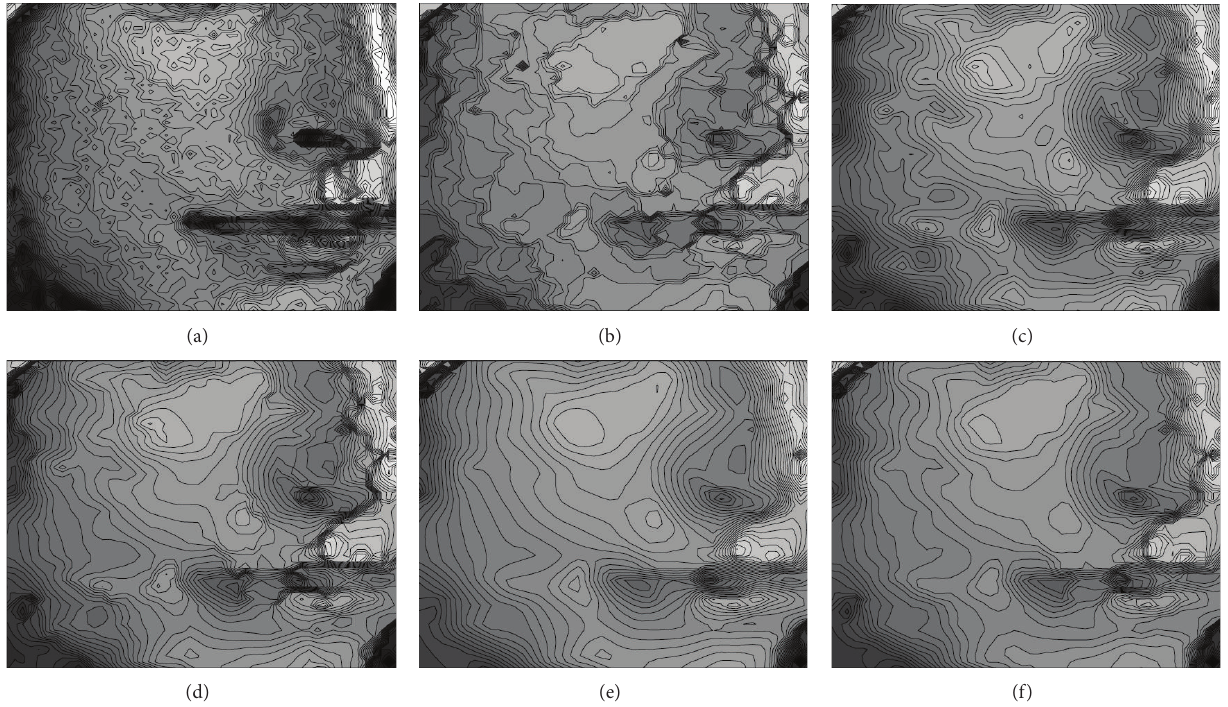
Figure 9: Contour plots corresponding to Figures 5(b)–5(f): (a) the ideal contour plot, results of (b) the ROF model, (c) the LLT model, (d) the hybrid model, (e) our Model 1, and (f) our Model 2.